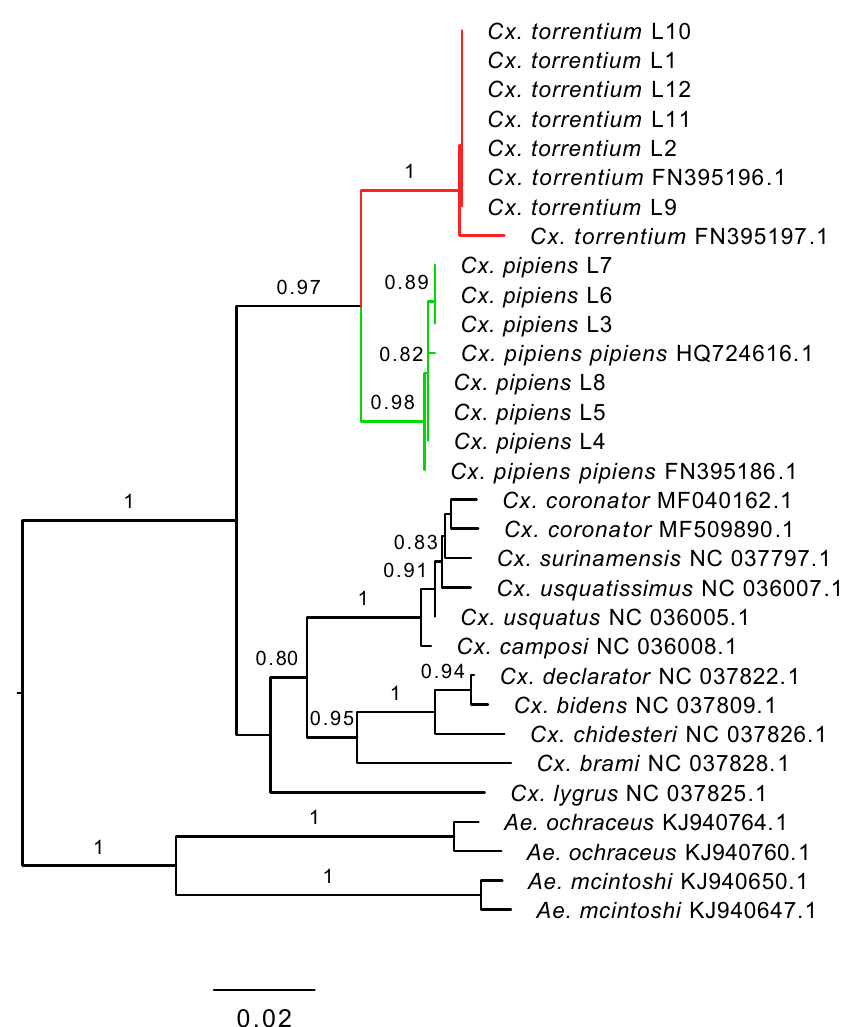
Figure 7. Phylogenetic relationships, based on partial COX1-gene, of Cx. pipiens and Cx. torrentium for all libraries (L1–L12) together with representative publicly available reference sequences (with their associated GenBank accession numbers). Numbers on branches indicate SH support, and only branches with SH support ≥ 80% are indicated. Branch lengths are scaled according to the number of nucleotide substitutions per site. The tree is midpoint rooted for clarity only.